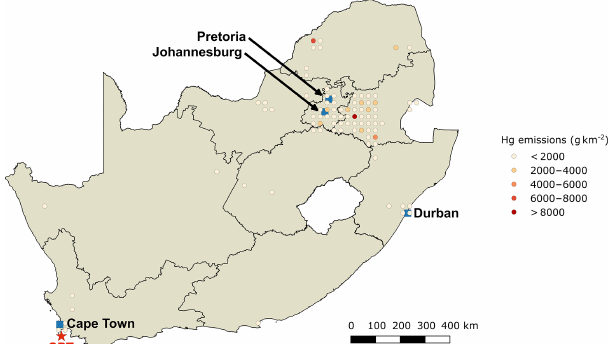
Figure 1. Location of the Cape Point site (CPT; red star), at the southernmost tip of the Cape Peninsula, and of known anthro- pogenic mercury emission sources (in gkm − 2 ; Global Mercury As- sessment 2018 emission inventory, Frits Steenhuisen, personal com- munication, July 2017) in South Africa. This map was made with